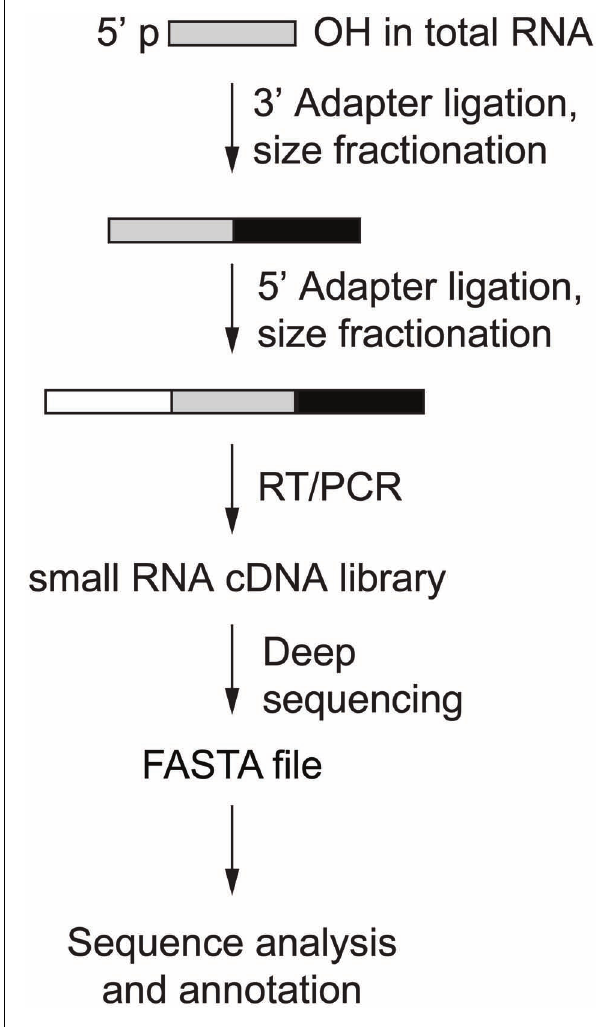
FIGURE 2 | Small RNA cDNA library preparation overview (Hafner etal.,